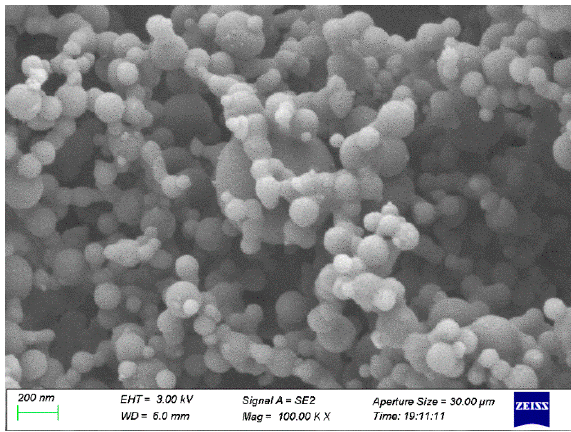
Figure 1. SEM morphology of Al nanoparticles.